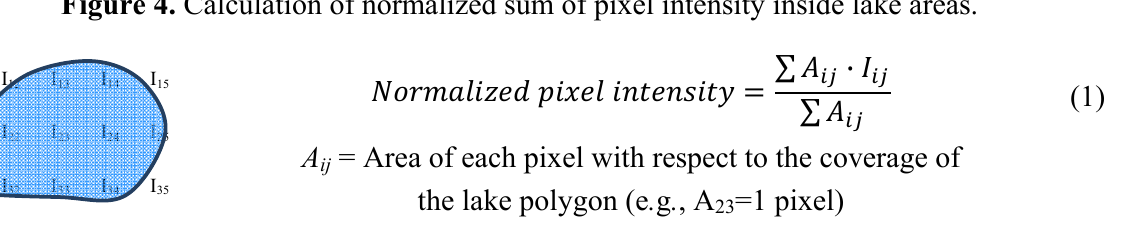
Figure 4. Calculation of normalized sum of pixel intensity inside lake areas.